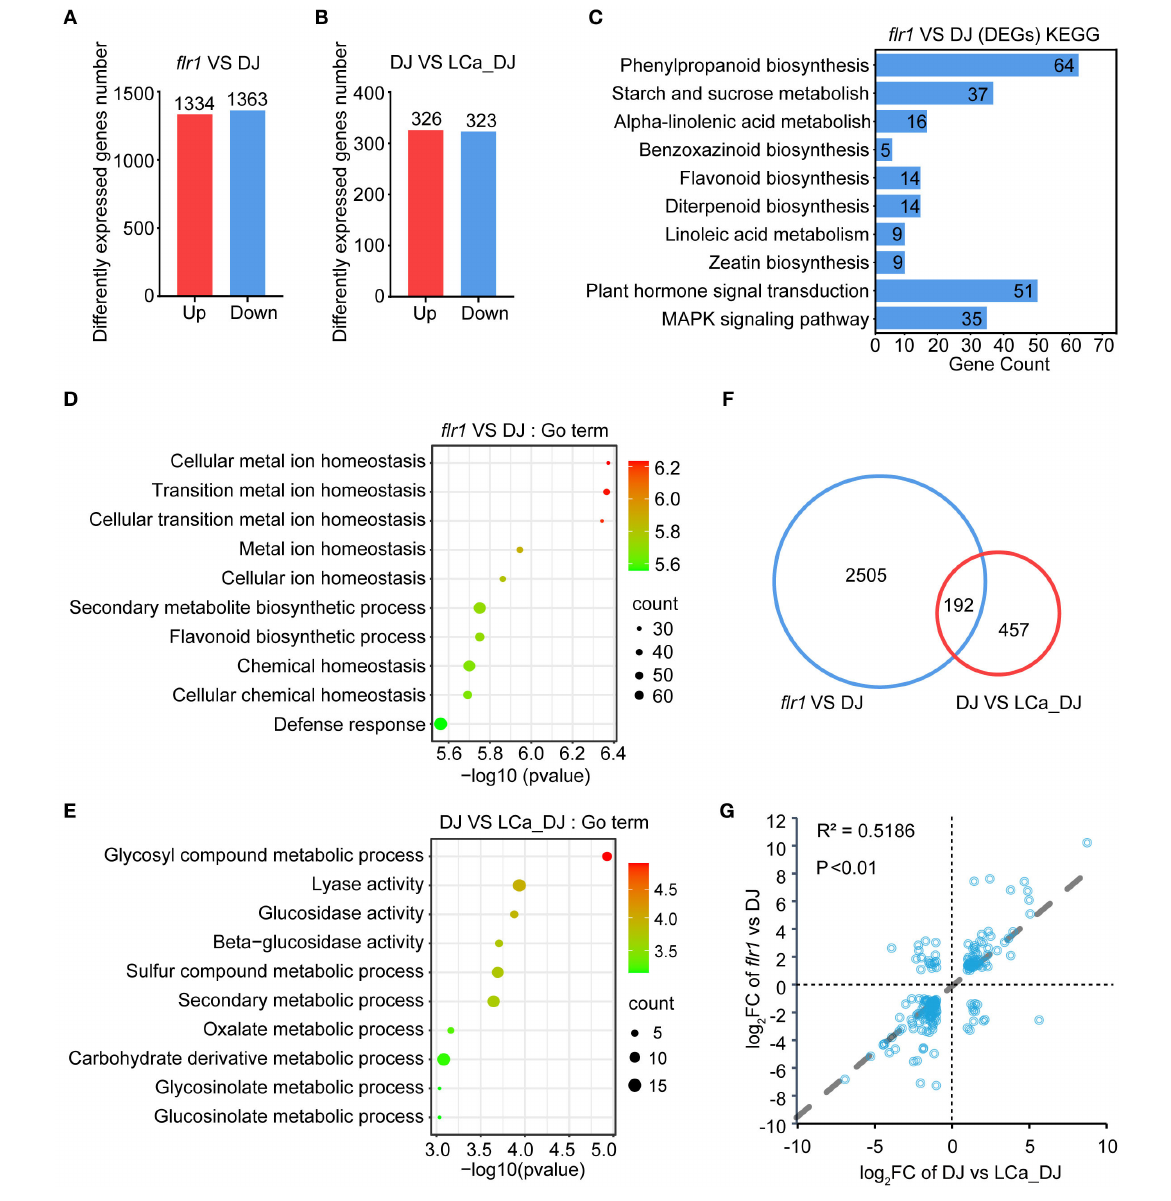
(Figure 5G). The correlation coefficients were high between flr1 vs. DJ and DJ vs. LCa_DJ, indicating a high degree of similarity for DEGs in the flr1 mutant and DEGs under Ca 2 + deficiency stress. Taken together, these results show that the flr1 mutant exhibits impaired resistance to M. oryzae in relation to Ca 2 + ion homeostasis.